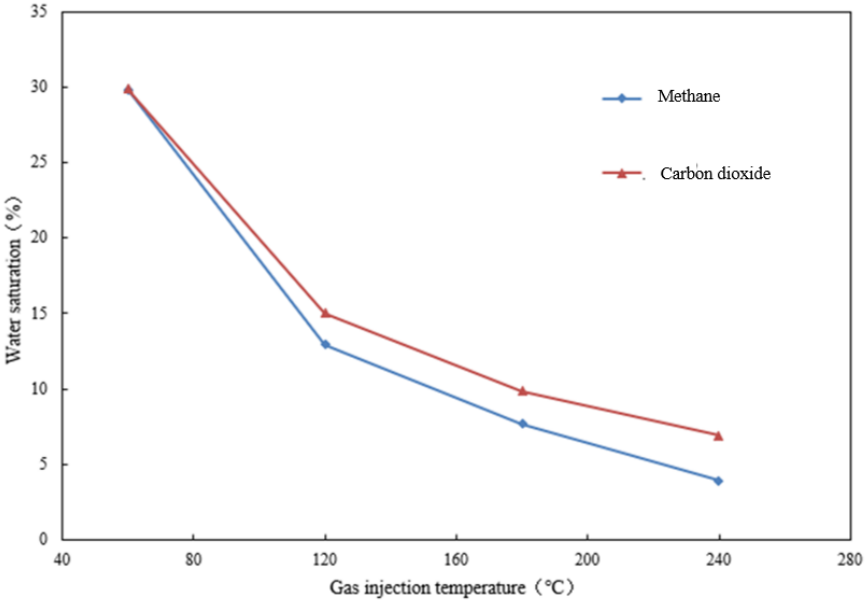
Figure 3. Relationship between gas-injection temperature and core water saturation.